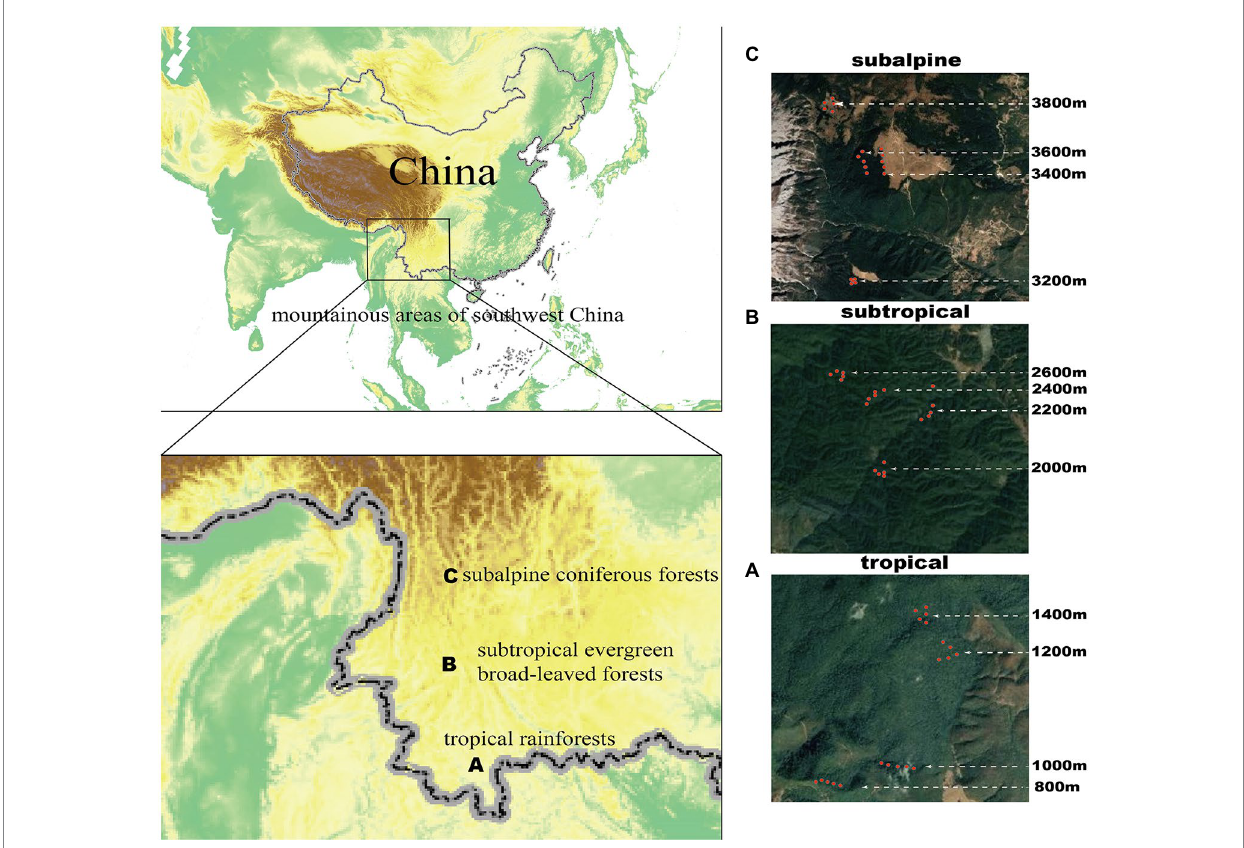
FIGURE 1 Surveyed sites in Yunnan Province, southwestern China. (A) Tropical region (Xishuangbanna Banma Mountain: 800, 1,000, 1,200, and 1,400 m); (B) Subtropical region (Puer Ailao Mountain: 2,000, 2,200, 2,400, and 2,600 m); (C) Subalpine region (Lijiang Yulong Snow Mountain: 3200, 3,400, 3,600, and 3,800 m). The red dots in A, B , and C represent the location of each